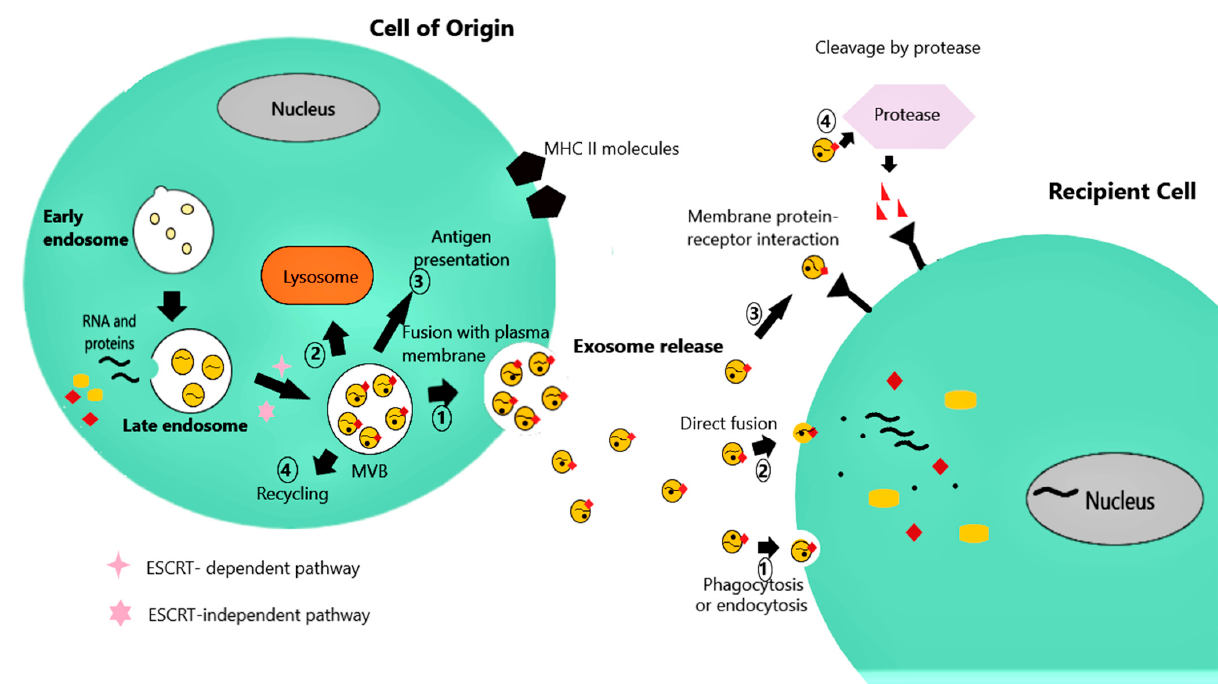
Figure 1. Exosome biogenesis and secretion . Exosomes are generated by reverse invagination of the membrane and incorporation of RNA cargo and proteins during endosome maturation to multivesicular bodies (MVBs). The assembly of exosomes is regulated either by the recruitment of the endosomal sorting complex required for transport endosomal sorting complex required for transport (ESCRT) complex (ESCRT-dependent pathway), or by different proteins such as the tetraspanins, and the lipid ceramide (ESCRT-independent pathway). Subsequently, MVBs can follow several pathways: (1) fusion with the plasma membrane and exosome release; (2) fusion with lysosomes for content degradation; (3) participation in antigen presentation in the plasma membranes by major histocompatibility complex (MHC) class II molecules; and (4) recycling. Upon release, exosomes can interact with the plasma membranes of target cells and trigger downstream effects by (1) phagocytosis or endocytosis; (2) direct fusion of exosome membrane with recipient cell membrane; (3) direct interaction of exosome membrane protein with recipient surface cell receptor; (4) cleavage by proteases of exosome membrane proteins and binding of the resulting fragments to recipient cell receptors.